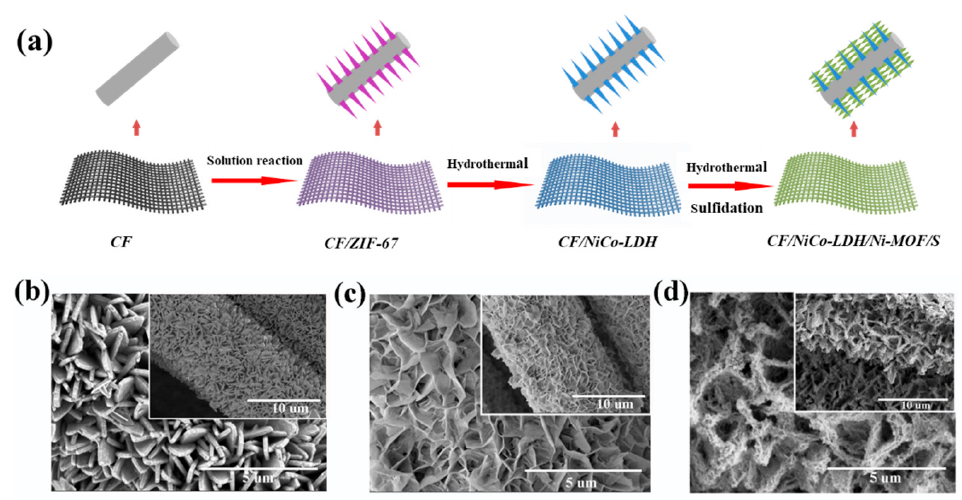
Figure 1. ( a ) Diagram illustrating the fabrication process of CC/NiCo LDH/S-Ni MOF electrode on carbon cloth, ( b – d ) Different magnification FESEM images of CC/Ni-Co LDH ( b ), CC/NiCo LDH/Ni MOF ( c ), and CC/NiCo LDH/S-Ni MOF ( d ).